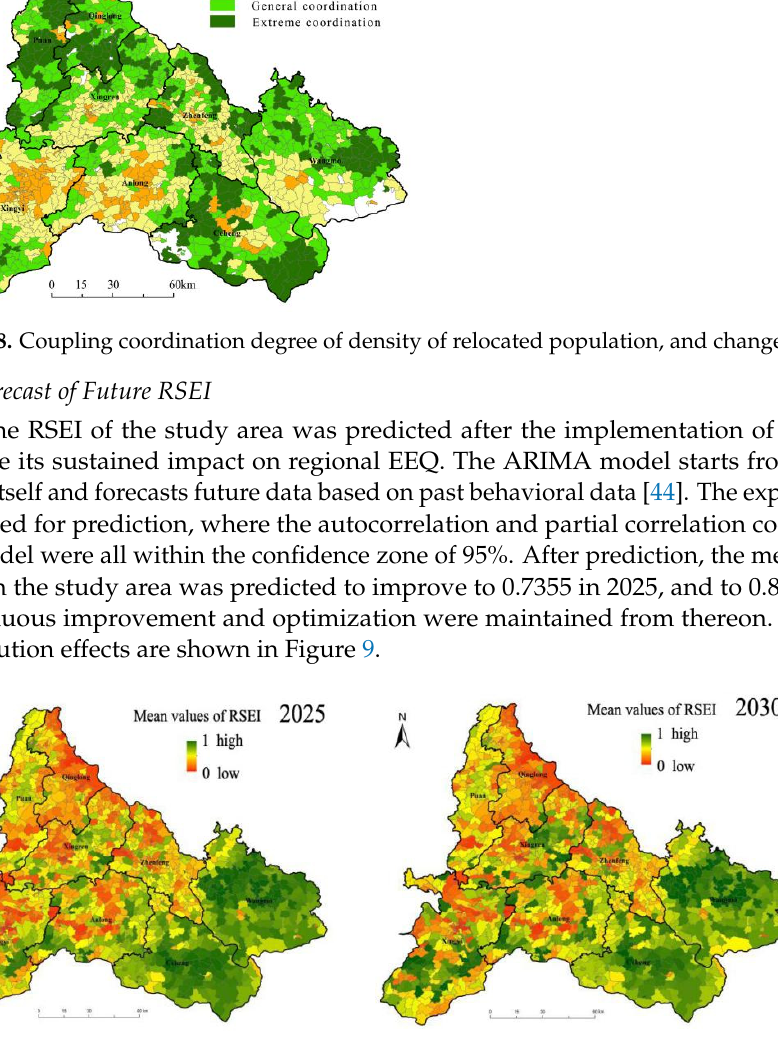
Figure 9. Forecast of the mean values of RSEI.